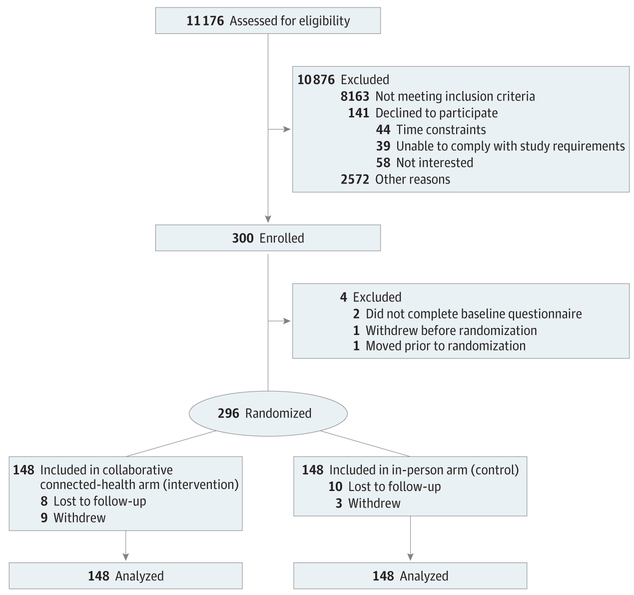
CONSORT Flow Diagram